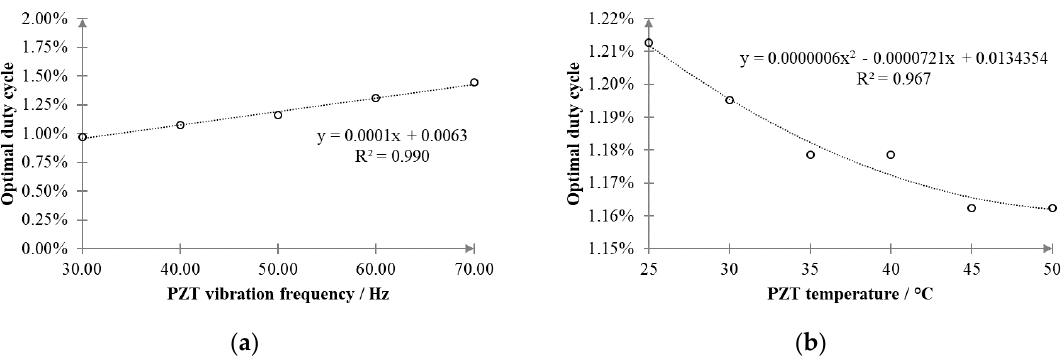
Figure 8. Effect of ( a ) the vibration frequency and ( b ) the temperature on the optimal duty cycle δ opt .